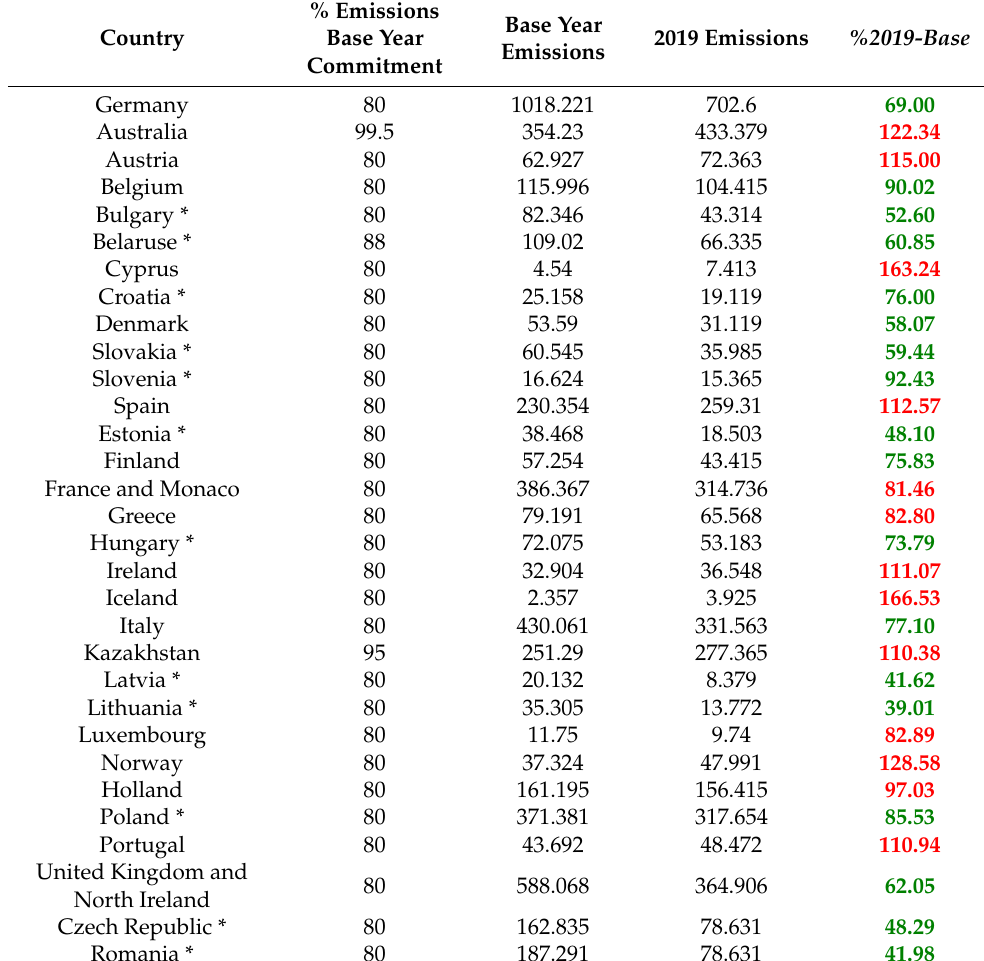
Table 8. Kyoto Protocol emissions analysis. Own